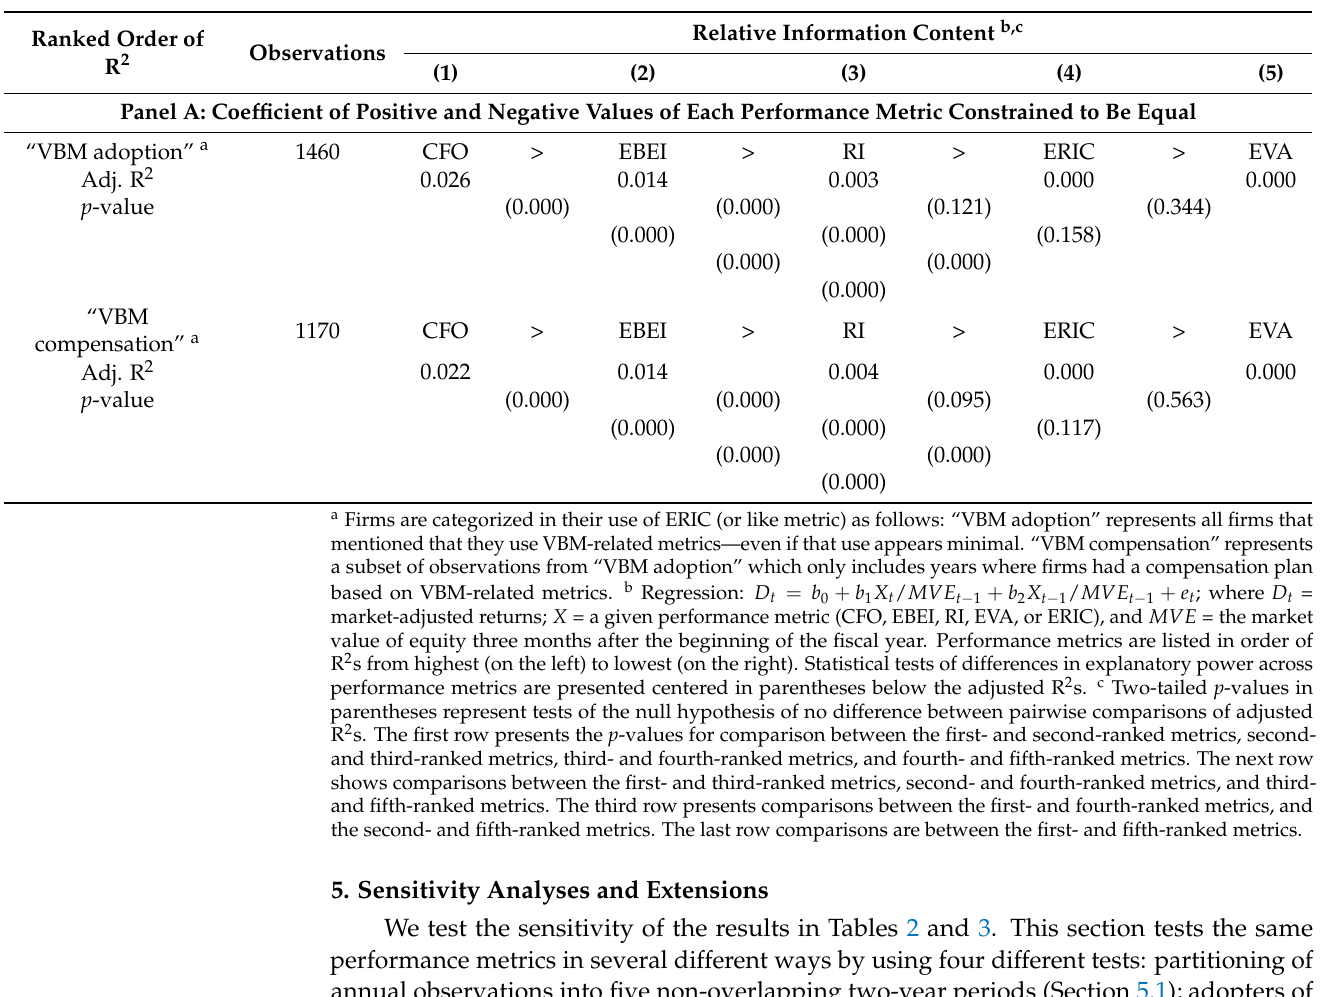
Table 4. Tests of relative information content of CFO, EBEI, RI, EVA, and ERIC for VBM adopters